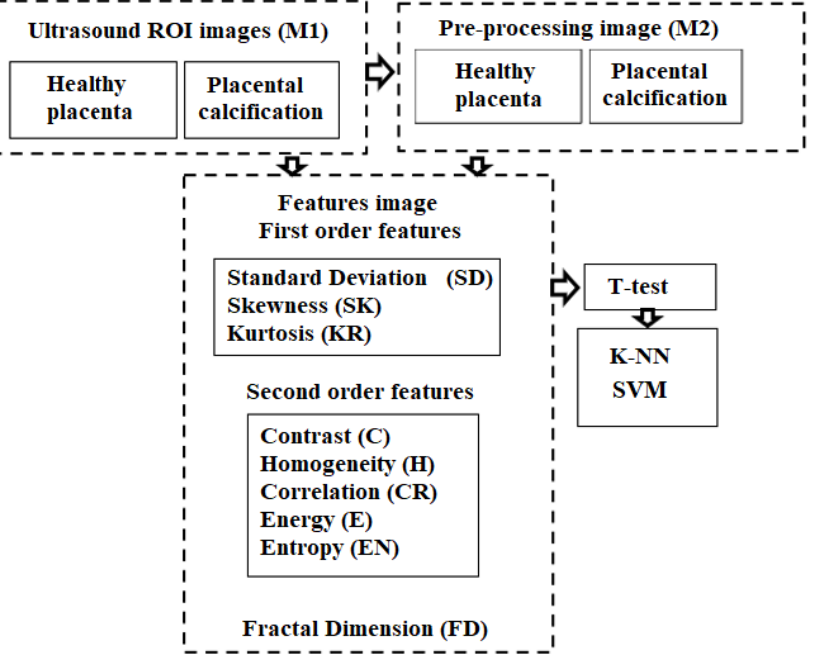
Figure 2. Algorithm diagram.